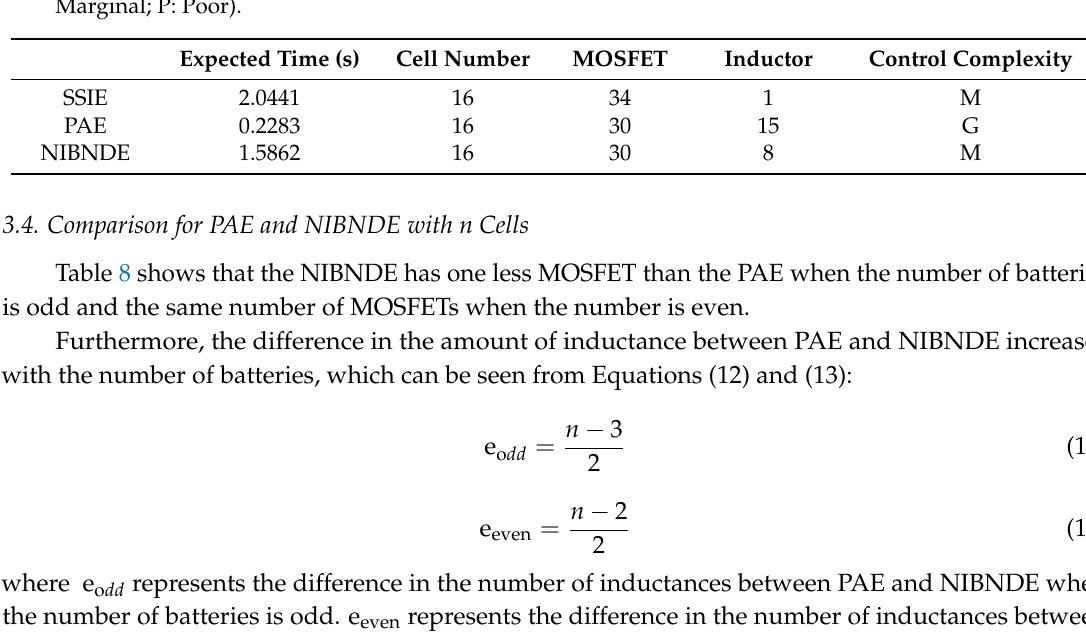
Table 8. The comparison between SSIE, PAE and NIBNDE in an n cell battery string ( 𝑛 ≥ 2 ).